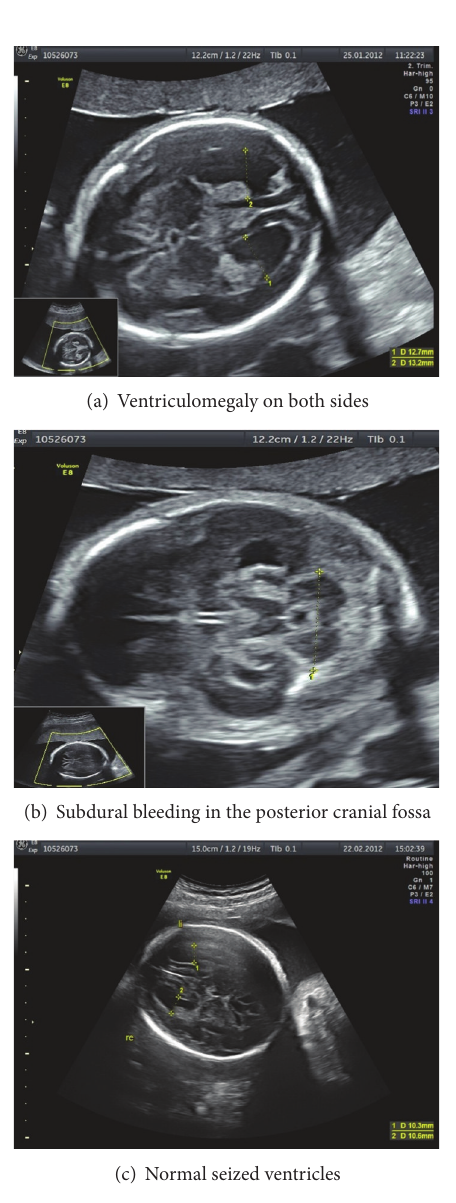
Figure 1: Sonographic